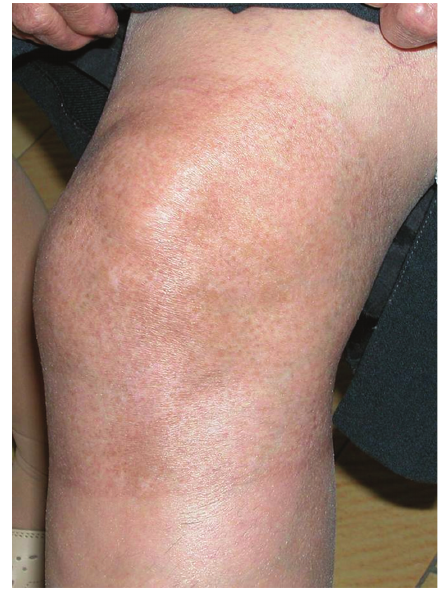
Figure 2: After conservative